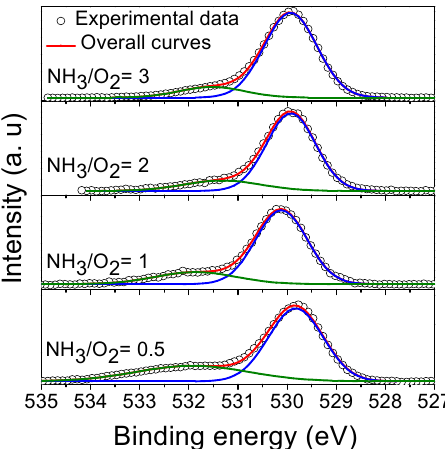
Figure 5. O 1 s XPS spectra of the films fabricated under various gas ratios.